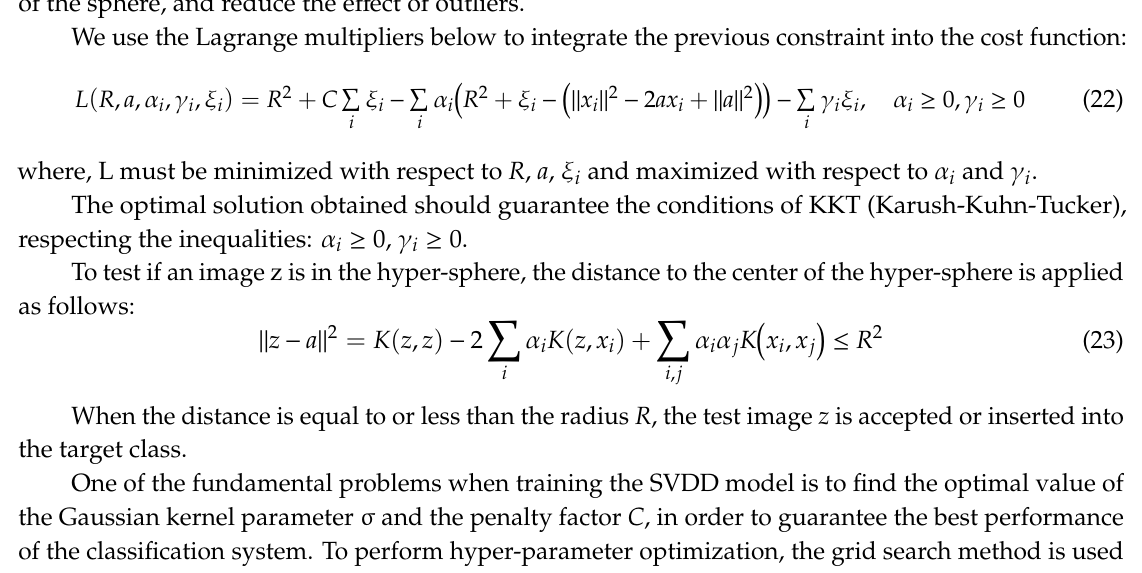
Figure 7. Outline of "divide and conquer" strategy for the division and training process based on the k-means clustering and SVDD sub-classifiers trained with only local support vectors (SV). 3.3.3. Computational Complexity